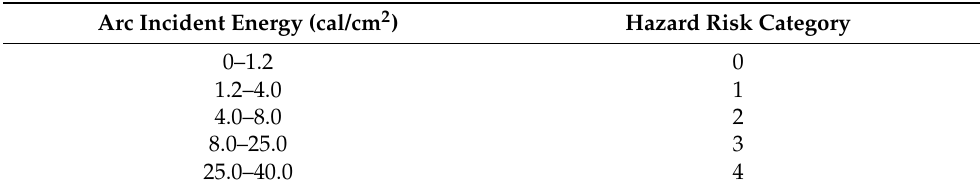
Table 2. Arc incident energy values and hazard risk categories